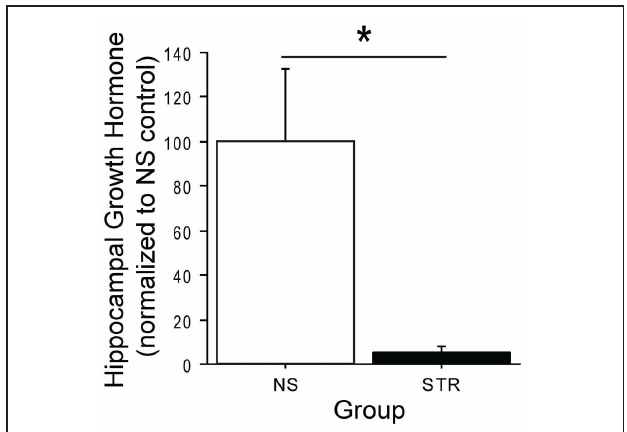
FIGURE 1 | Chronic stress reduces hippocampal growth hormone (GH). Hippocampal GH levels were assayed seven days after a two week period of immobilization stress (STR; n = 4) or handling (NS; n = 4). GH levels were expressed as a percentage, relative to the NS control average. GH was significantly lower in the hippocampi of stressed rats relative to unstressed rats. *Indicates p < 0 .